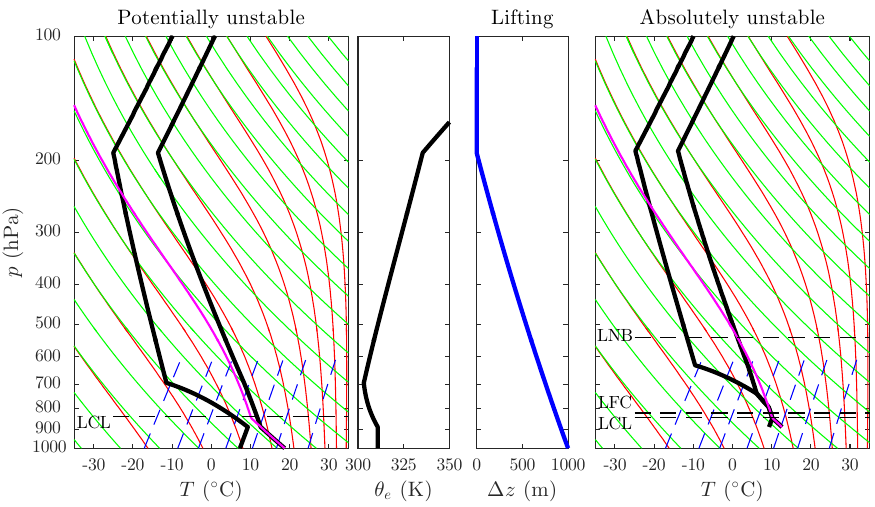
Figure 2. Left two panels: as in Figure 1, but for an initially absolutely stable and potentially unstable environment. Right two panels: through lifting by ∆ z ( p ) , the ∼ 800–700 hPa layer becomes absolutely